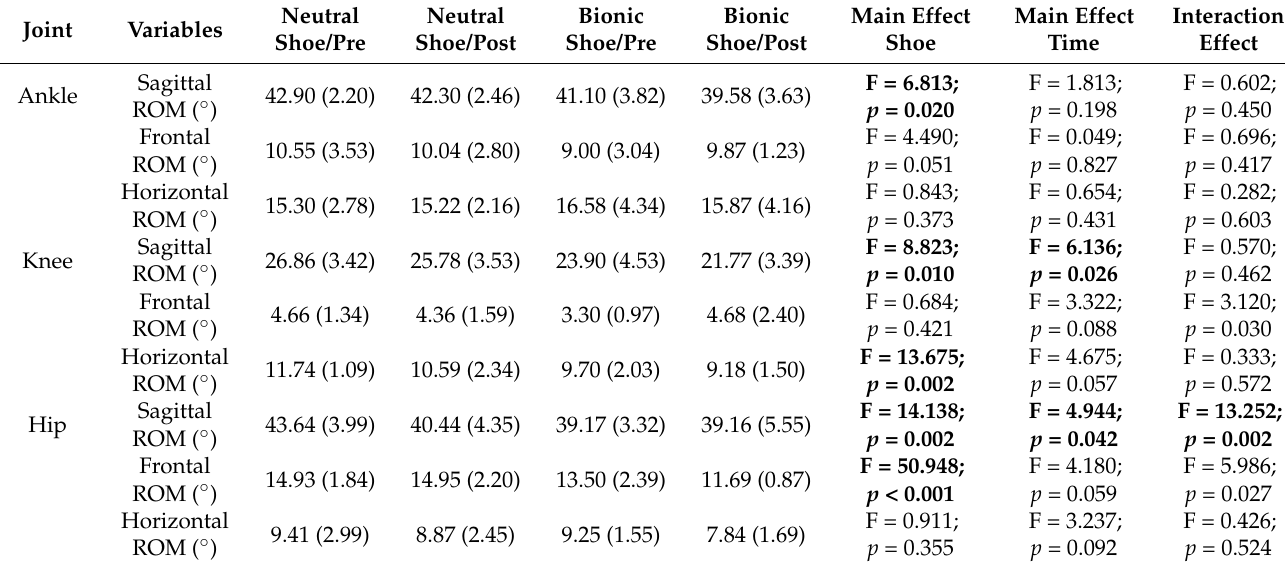
Table 1. Mean (SD) of angle range of motion (ROM) of the stance phase for the four experimental